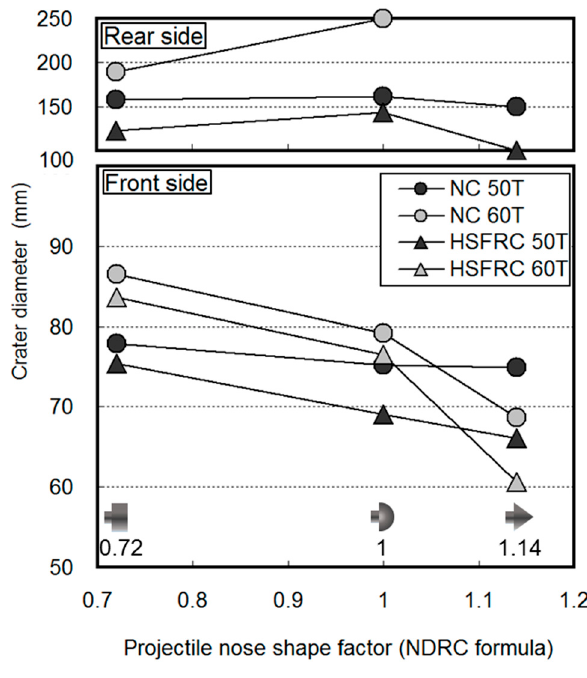
Figure 12. Crater diameter.